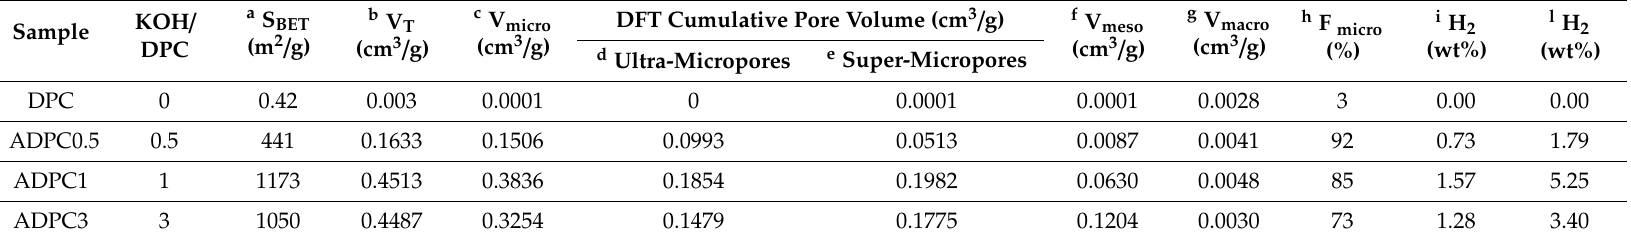
Table 1. Textural properties and H 2 adsorption properties of the